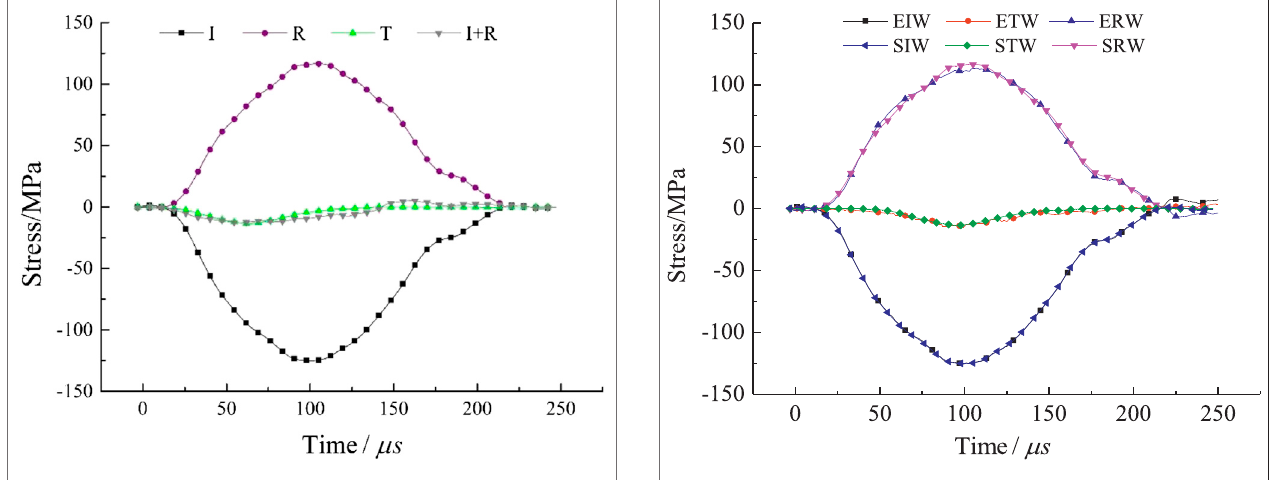
FIGURE 3 | Incident (I), reflected (R), transmitted (T), and incident + re fl ected (I + R) stress wave of the dynamic tensile experiment.